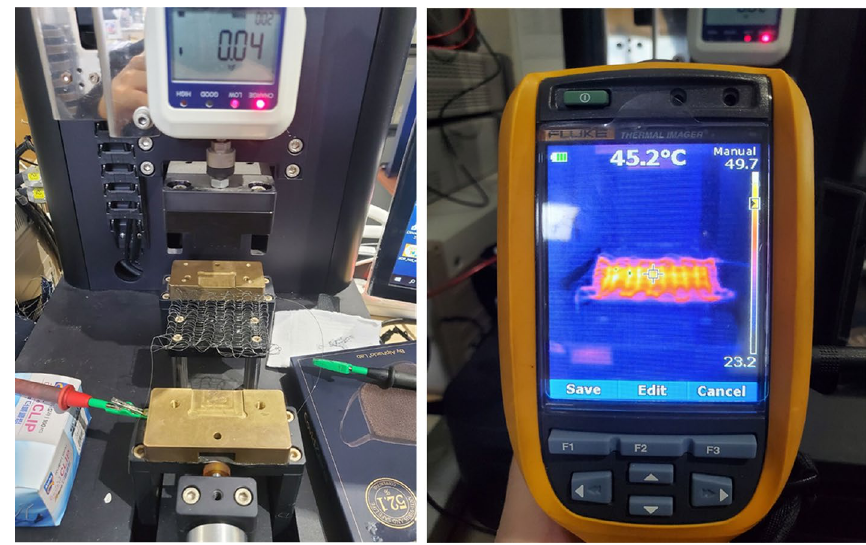
Fig. 4 Measuring driving force of real shape memory textile actuator with Universal Testing Machine